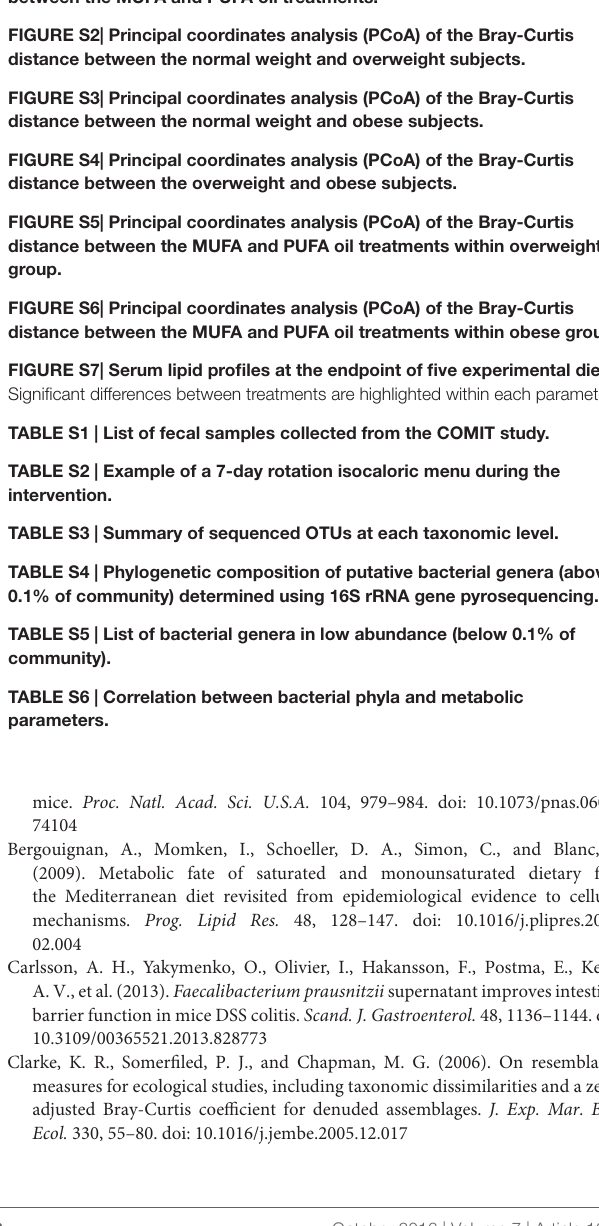
FIGURE S2| Principal coordinates analysis (PCoA) of the Bray-Curtis distance between the normal weight and overweight subjects. FIGURE S3| Principal coordinates analysis (PCoA) of the Bray-Curtis distance between the normal weight and obese subjects. FIGURE S4| Principal coordinates analysis (PCoA) of the Bray-Curtis distance between the overweight and obese subjects. FIGURE S5| Principal coordinates analysis (PCoA) of the Bray-Curtis distance between the MUFA and PUFA oil treatments within overweight group.